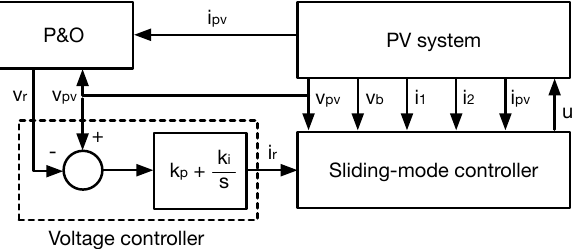
Figure 10. Complete control